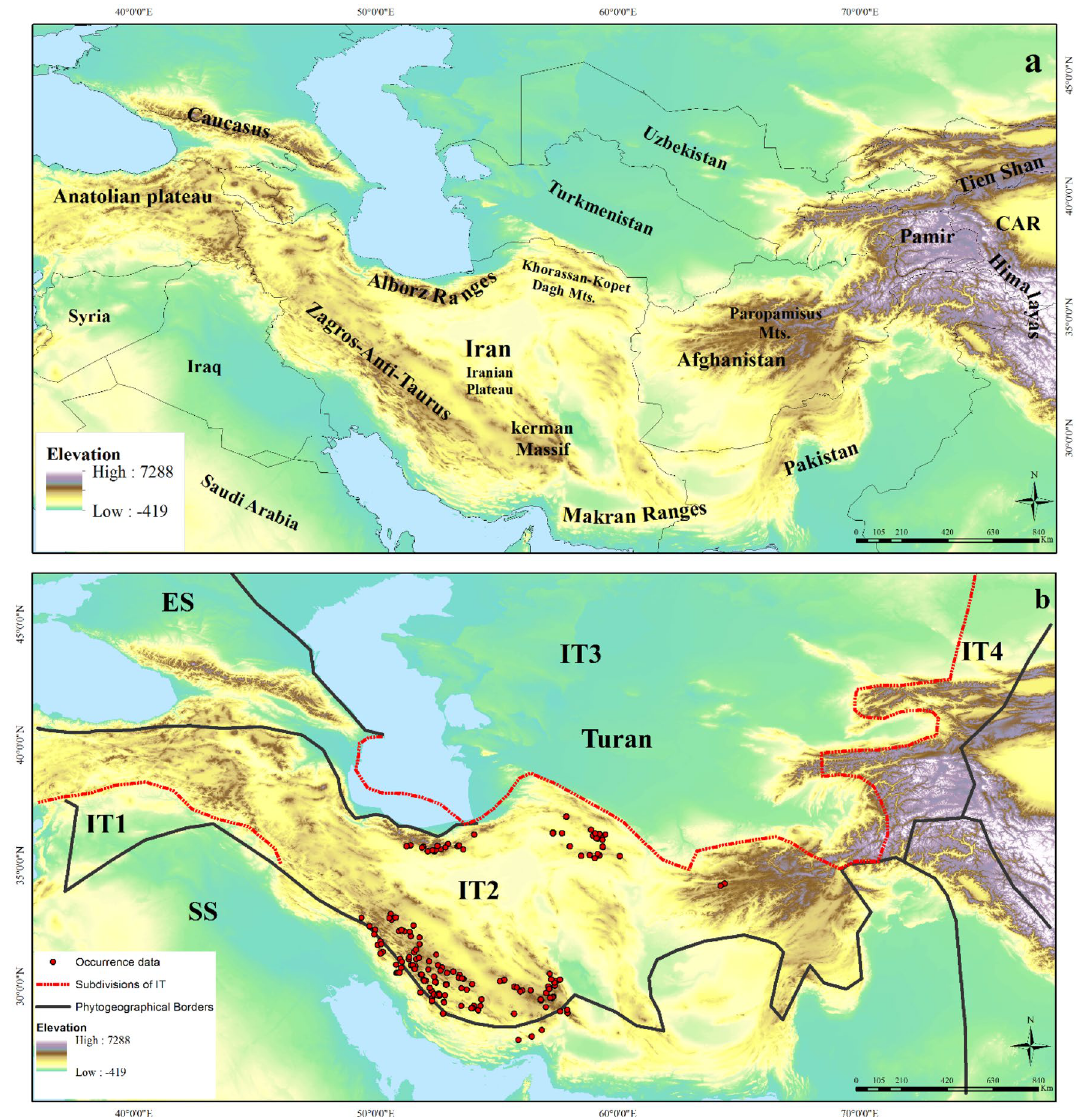
Figure 1. The study area and distribution of Nepeta glomerulosa in southwestern and central Asia: ( a ) Topographic map of mountain areas across southwestern and central Asia, ( b ) Phytogeographical borders: IT; Irano–Turanian region, ES; Euro-Siberian region, and SS; Saharo-Sindian region (Phytogeographical borders is taken from Behroozian et al. 2 ) (ArcGIS version 10.3.1; http:// www. esri.